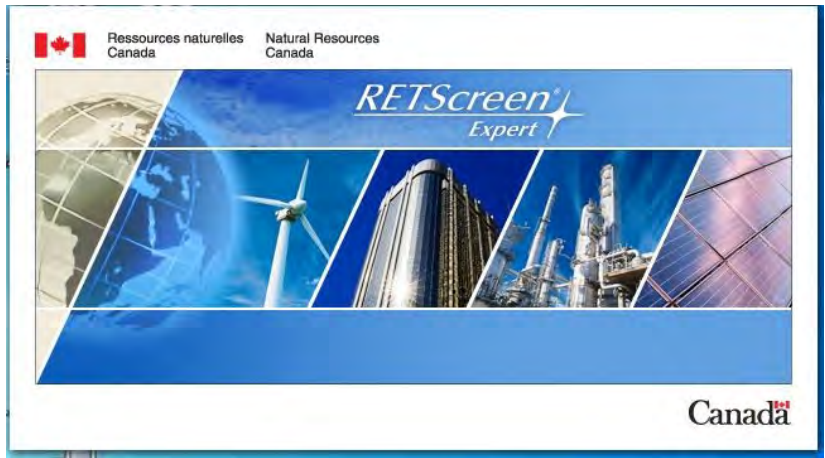
Figure 8. Program’s main interface (”Renewable Energy Technologies Screen”, n.d.)